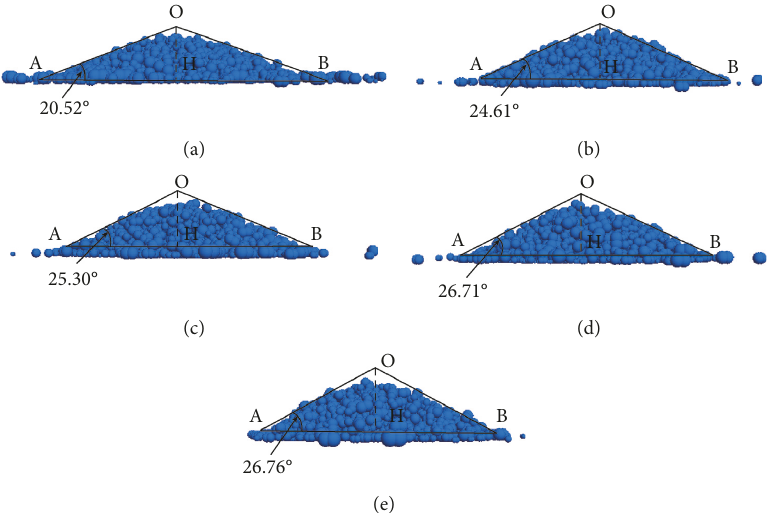
Figure 10: Particle piles for 2-ball with overlap model under different μ � 0 . 6. (e) μ s , pp